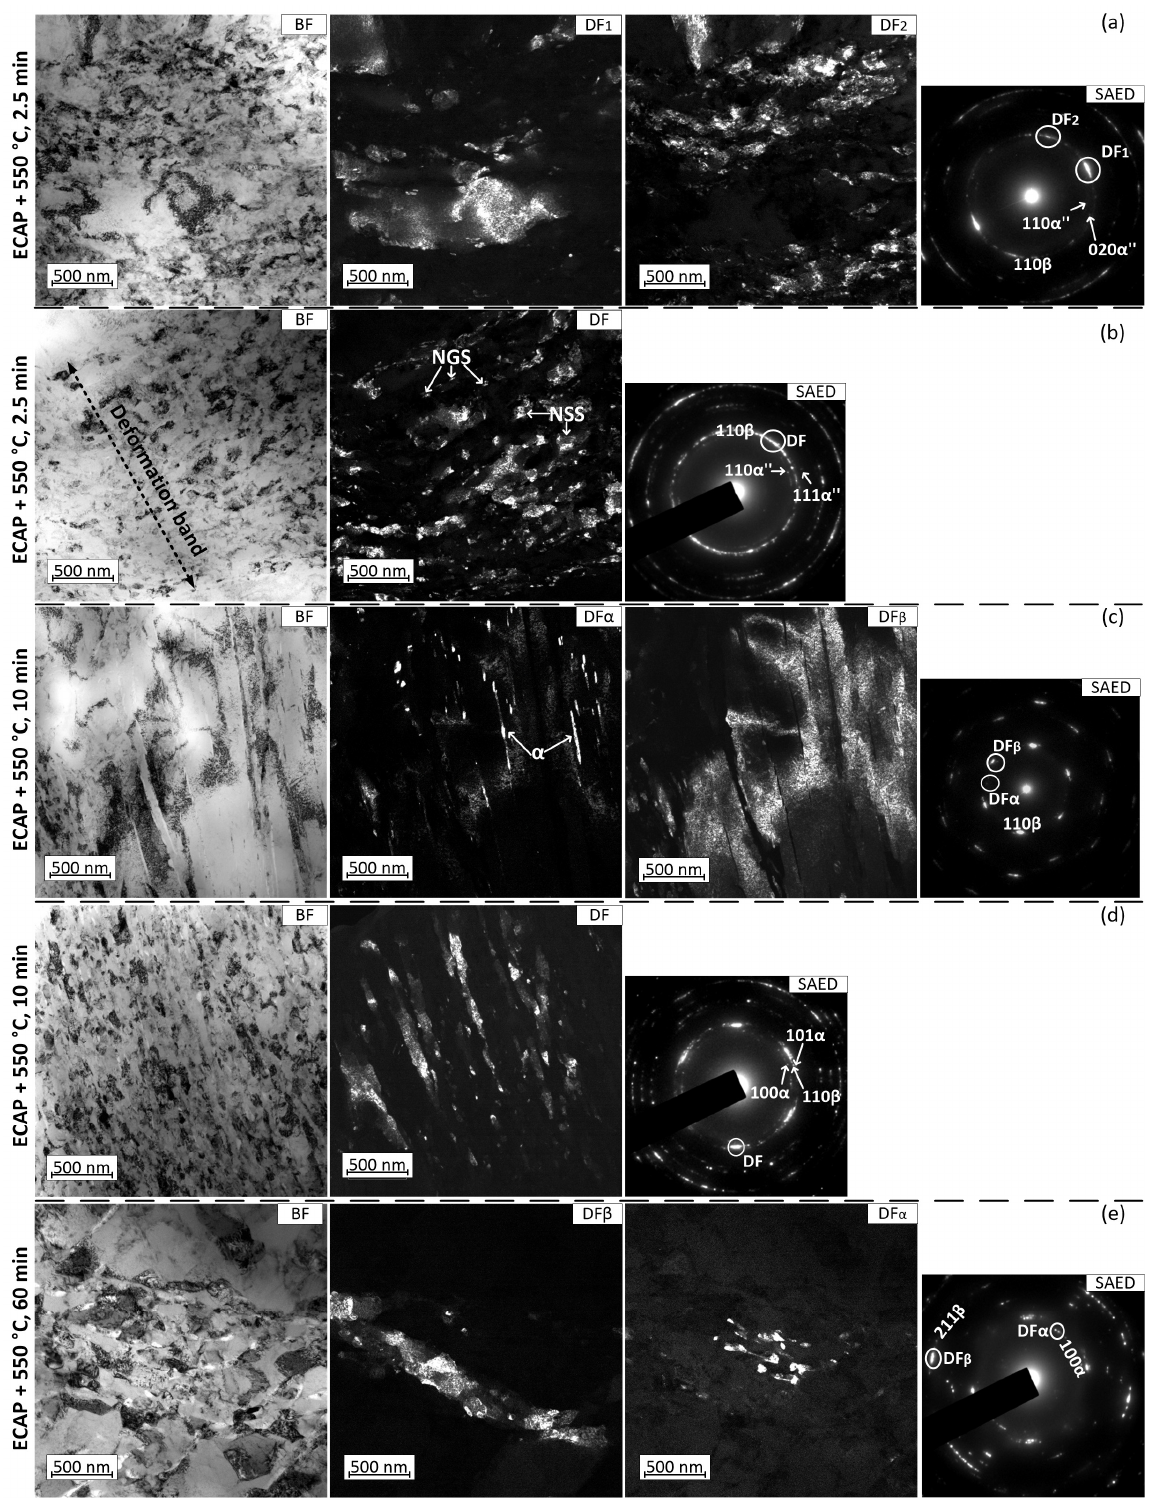
Figure 6. TEM images of the Ti ‐ 18Zr ‐ 15Nb alloy after: ( a , b ) ECAP + PDA 550 °C, 2.5 min; ( c , d ) ECAP + PDA 550 °C, 10 min; ( e ) ECAP + PDA 550 °C, 60 min. Bright field (BF) and dark field (DF) images, and SAED patterns.